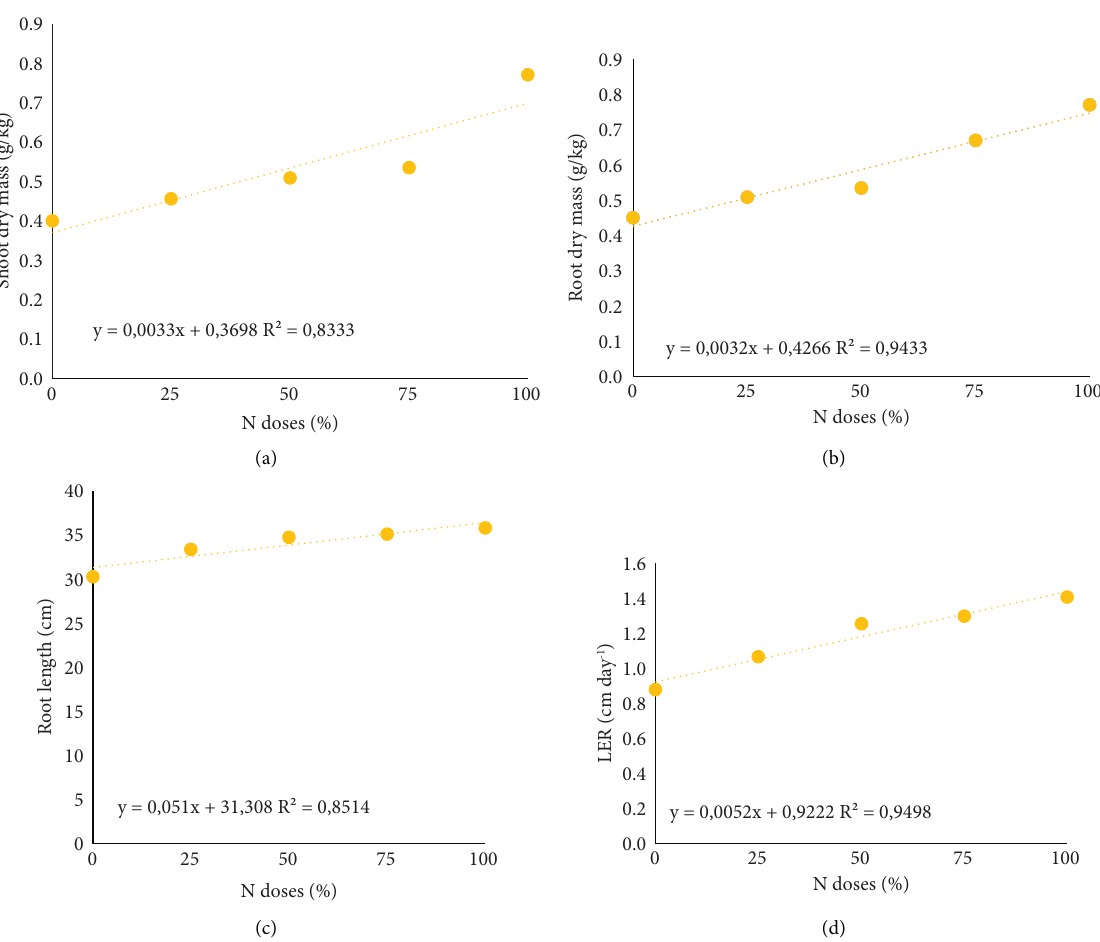
Figure 4: Isolated efect of reduced nitrogen doses on shoot dry mass (a), root dry mass (b), root length (c), and leaf elongation rate (d) of Urochloa brizantha cv.